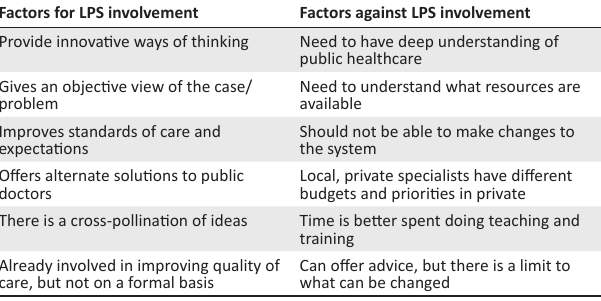
TABLE 3: Factors for and against local, private specialists involvement in clinical governance at rural district